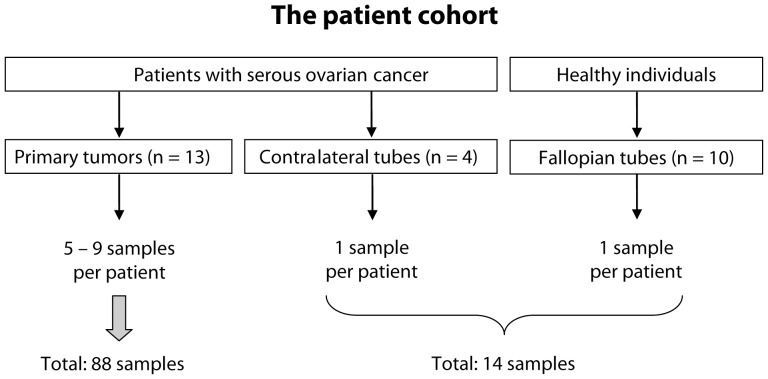
Schematic illustration of patient cohort and sample selection.